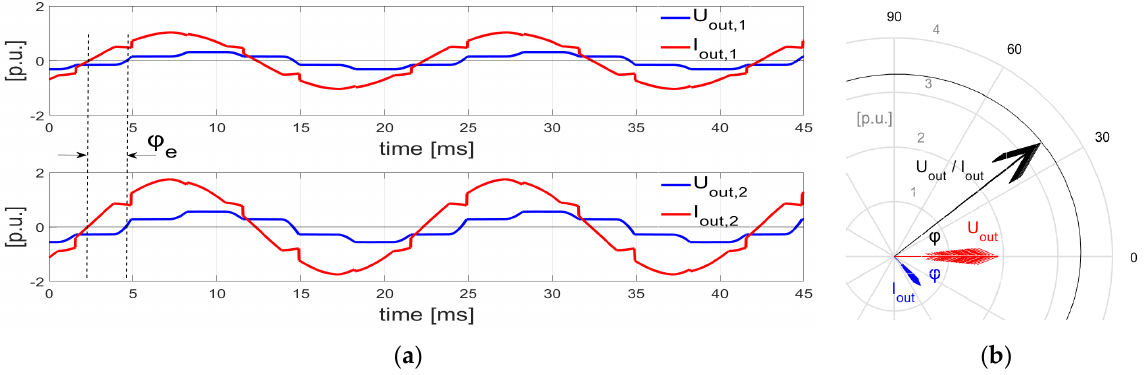
Figure 7. Constant impedance equivalence property study: ( a ) Exciter output current ( I out ) and line voltage ( U out ) waveforms (Upper Figure: P 1 = 250 kW, Q 1 = 0 kvar and Bottom Figure: P 2 = 1500 kW, Q 2 = 0 kvar ); ( b ) Per-unit phasor diagram.